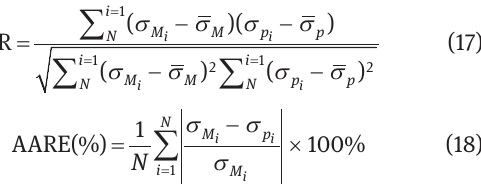
Fig. 7: Relationships between a and true strain